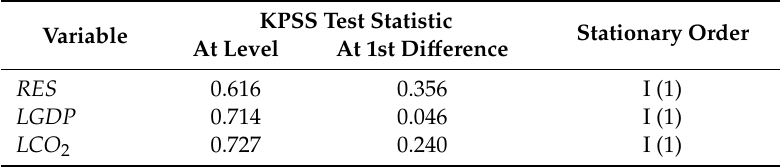
Table 3. The unit root test at the level of variables (intercept included) [29].